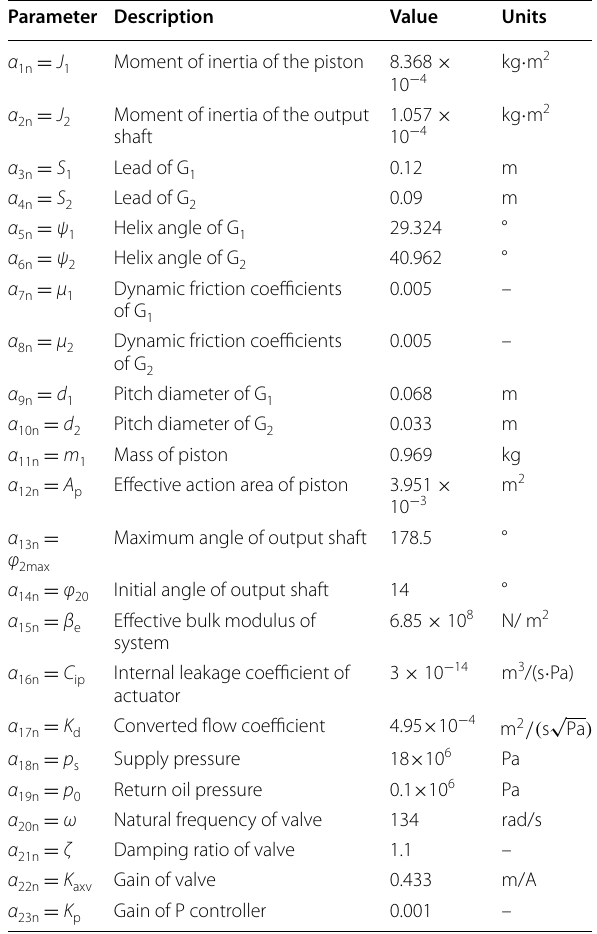
Table 1 Nominal value of parameters Parameter